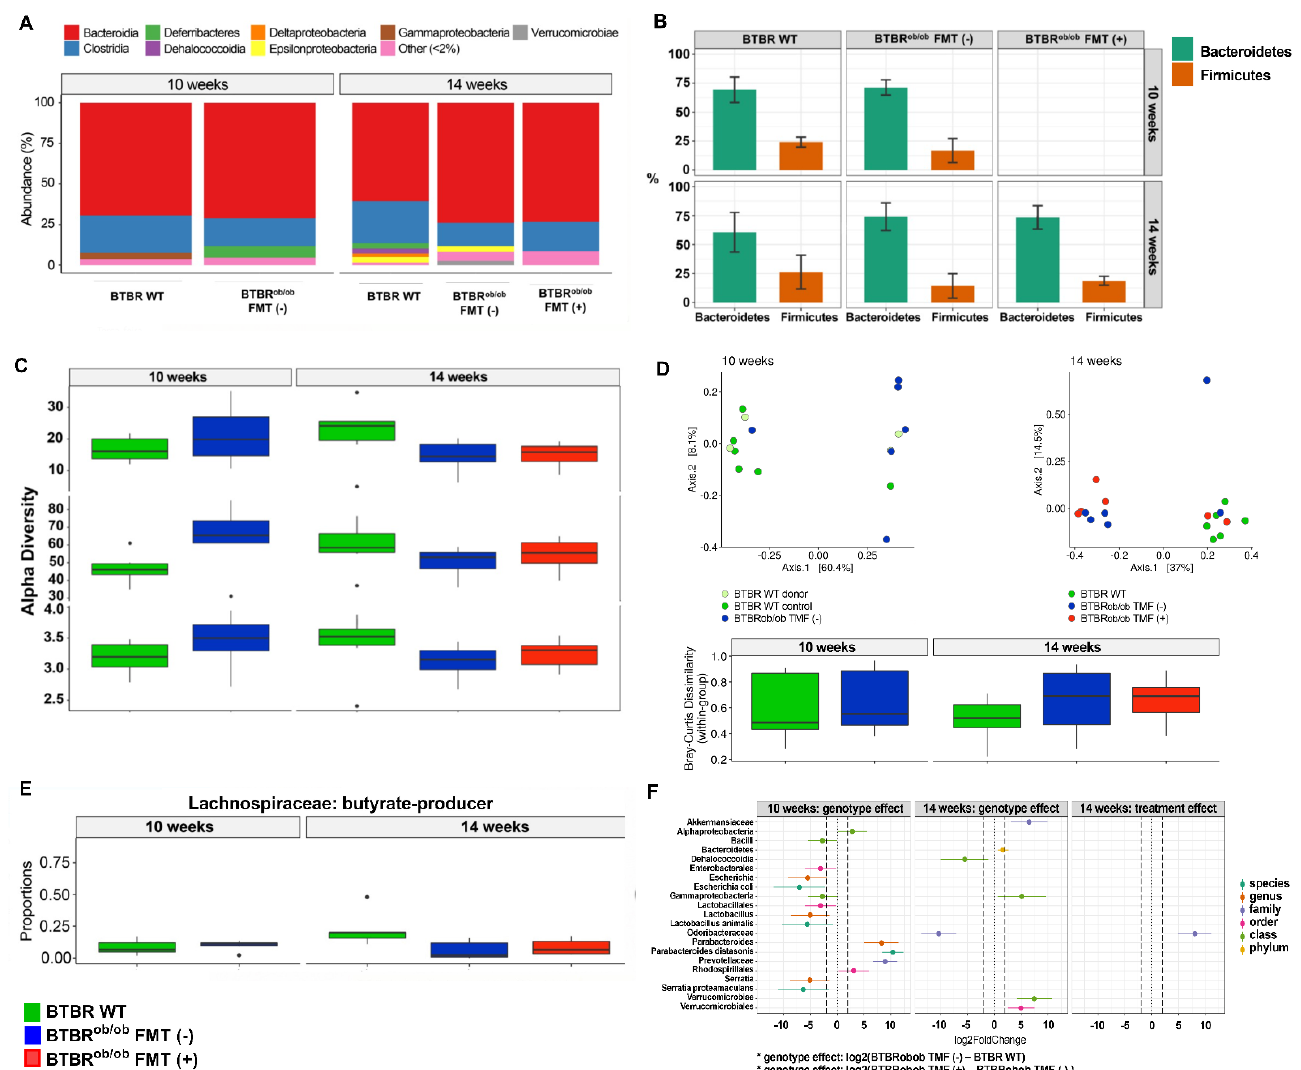
Figure 1. Intestinal composition analysis by 16S rRNA sequencing in BTBR ob/ob FMT (+) and BTBR ob/ob FMT ( − ) mice compared to BTBR WT mice. ( A ) Bacterial phyla according to 16S rRNA sequencing of 10- and 14-week-old BTBR ob/ob FMT (+) and FMT ( − ) mice compared to age-matched BTBR WT mice: Bacteroidetes, Firmicutes, Proteobacteria, Actinobacteria, Verrucomicrobia, Deferribacteres, and Chloroflex. ( B ) Alpha diversity analysis by Shannon Index in 10-week-old BTBR WT and age-matched BTBR ob/ob mice ( p = 0.24), and among 14-week-old BTBR WT versus BTBR ob/ob FMT ( − ) and BTBR ob/ob FMT (+) mice ( p = 0.21) indicated that the species richness was similar among groups. Results are median and IQR. ( C ) Principal coordinate analysis (PCoA) based on Bray–Curtis dissimilarity metrics did not show any clearly associated clusters in relation to the study animals. Results are median and IQR. ( D ) Butyrate producer Lachnospiraceae bacteria family proportions were similar between 10-week-old BTBR WT and age-matched BTBR ob/ob mice ( p = 0.59), yet higher proportions of these bacteria in 14-week-old BTBR WT compared to 14-week-old BTBR ob/ob FMT ( − ) and FMT (+) mice (* p = 0.026) were observed. No significant difference was found between 14-week-old BTBR ob/ob FMT (+) and FMT ( − ) mice ( p = 0.39). Results are median and IQR. ( E , F ) Assessment of the differences in relative abundance between genotypes effect evaluated by log 2-fold change demonstrated greater relative abundance in the Gammaproteobacteria and Verrucomicrobiae classes and lower abundance in the Dehalococcoidia and Odoribacteraceae families in 14-week-old BTBR ob/ob FMT ( − ) mice. The treatment increased the abundance of the Odoribacteraceae family in 14-week-old BTBR ob/ob FMT (+) mice. In all analyses, n =